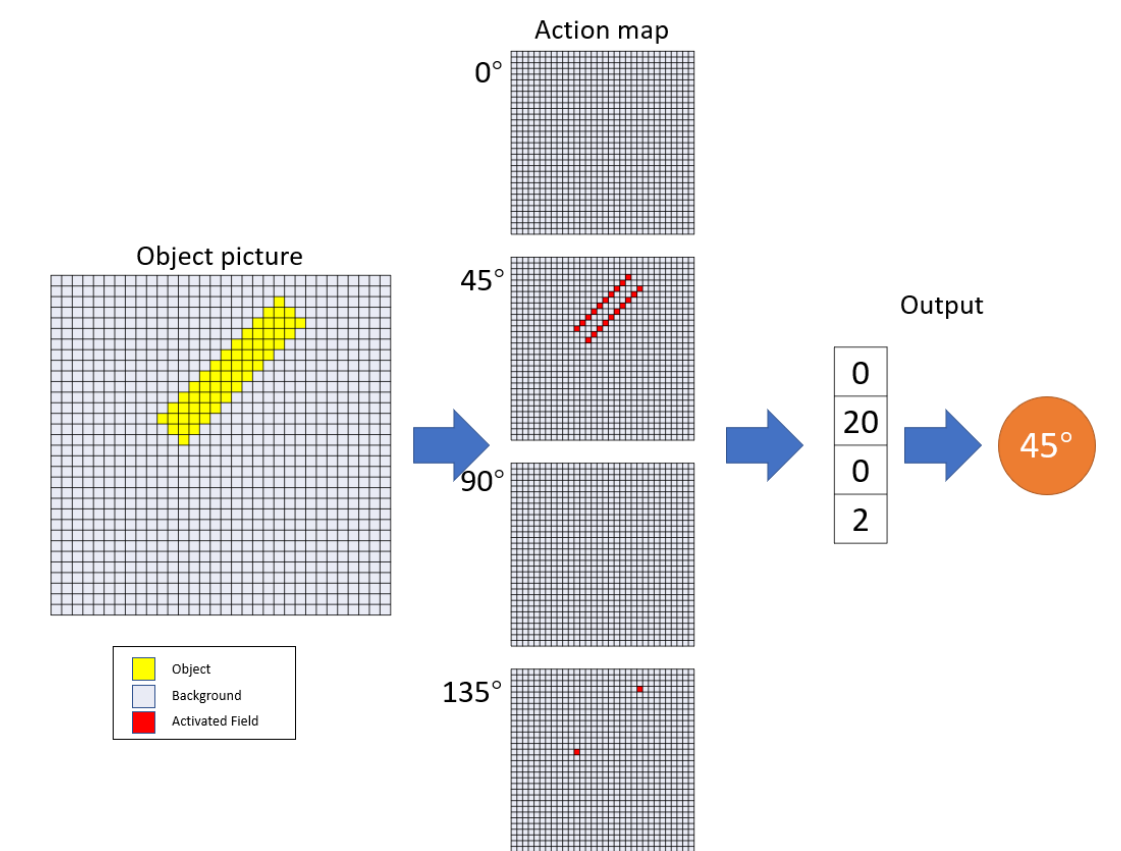
Figure 11. A total of 56 pixels, 45 degree and action